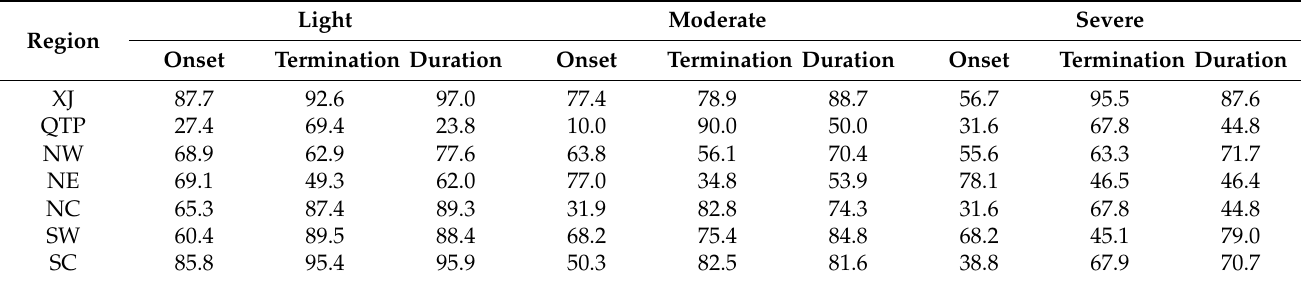
Table 5. Area percentage (%) of advanced heatwave onset, delayed heatwave termination, and increasing heatwave duration in seven subregions of